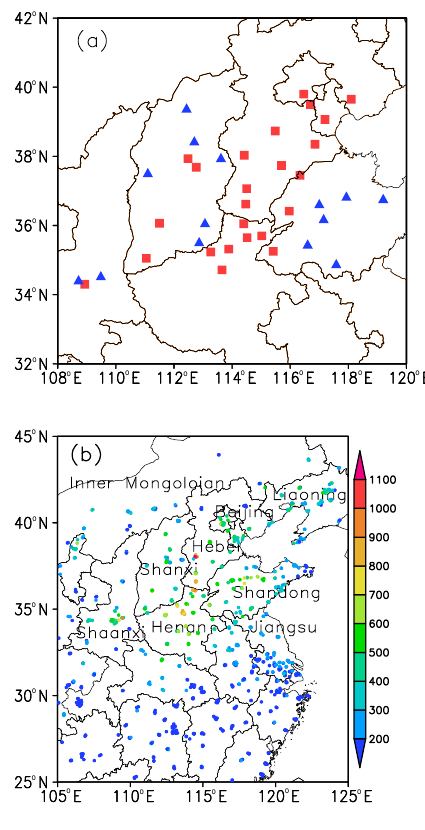
Figure 4. (a) The measures to limit anthropogenic emissions and (b) the maximum hourly PM 2 . 5 concentration during 16–21 De- cember 2016. In panel (a) , the red rectangle indicates both the ve- hicle control and production restriction measures that were imple- mented, while the blue triangle indicates the production that was restricted. The letters in panel (b) were the names of the